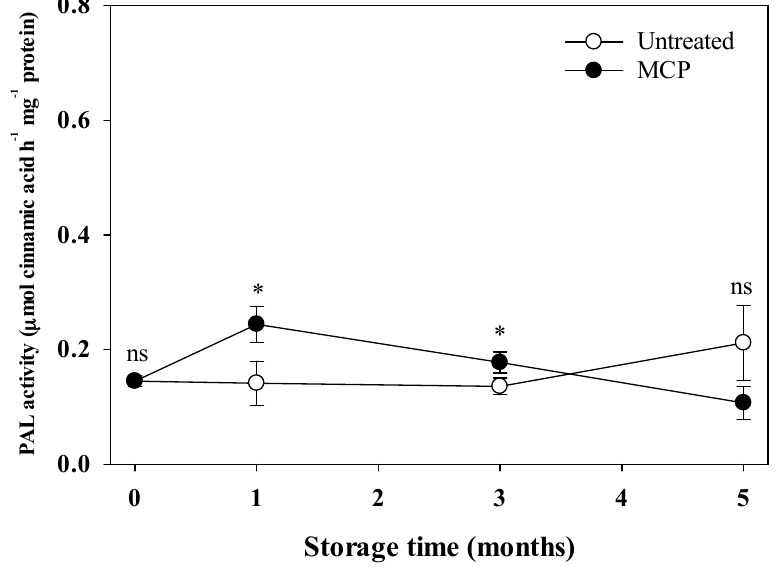
Figure 4. PAL (Phenylalanine ammonia lyase) activity in flesh tissue on ‘Empire’ apples, either untreated or treated with 1 µL·L − 1 1-MCP, and stored at 0.5 °C in air storage for up to 5 months. Bars represent error of the means (S.E.M; n = 5), when larger than the dimension of the symbol. ns and * indicate non-significant and significant differences between untreated and 1-MCP treatments at p < 0.05, respectively.